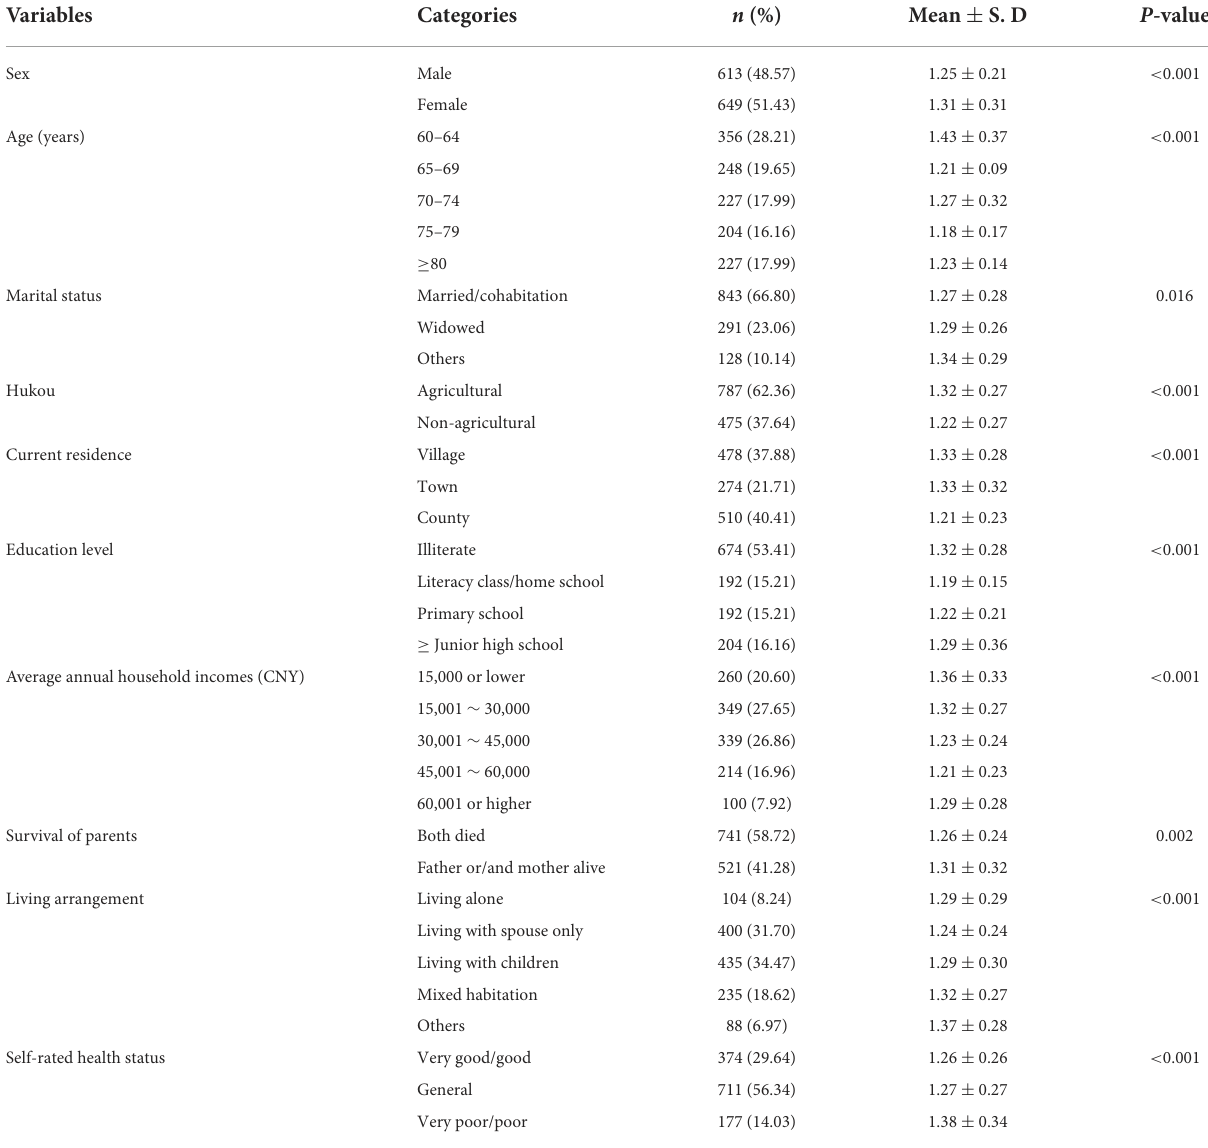
TABLE 1 Participants’ demographic characteristics and the total scores of SCL-90-R ( n = 1,262). Variables